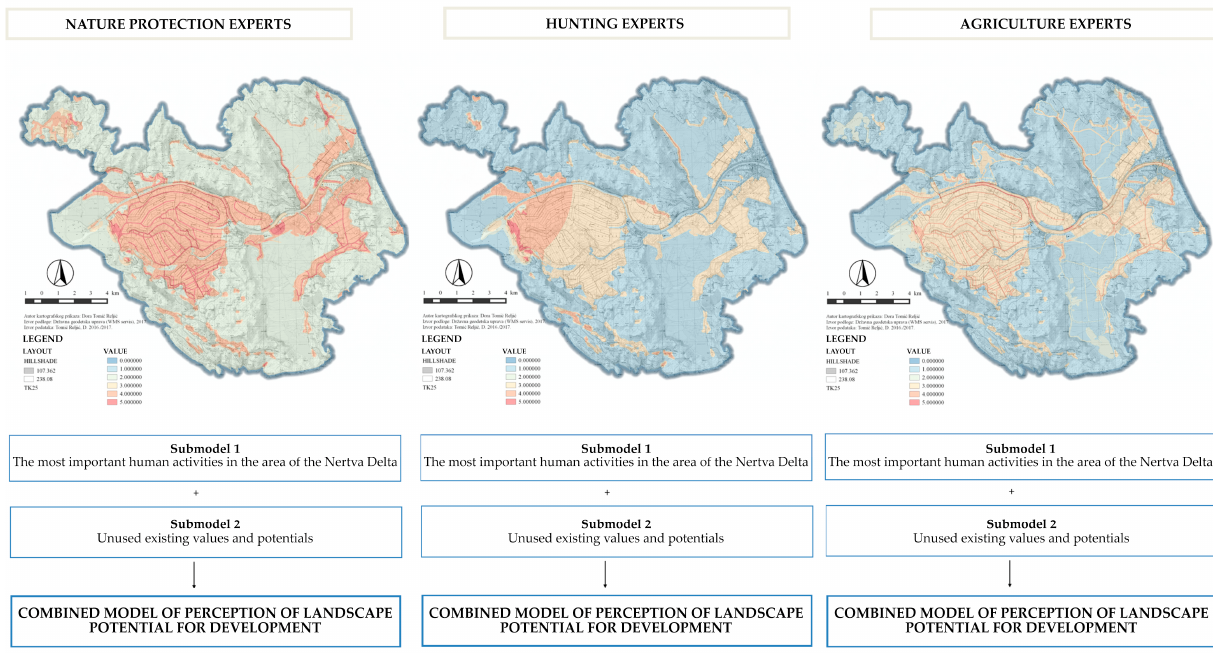
Figure 4. The process of creating models of landscape potential for development .